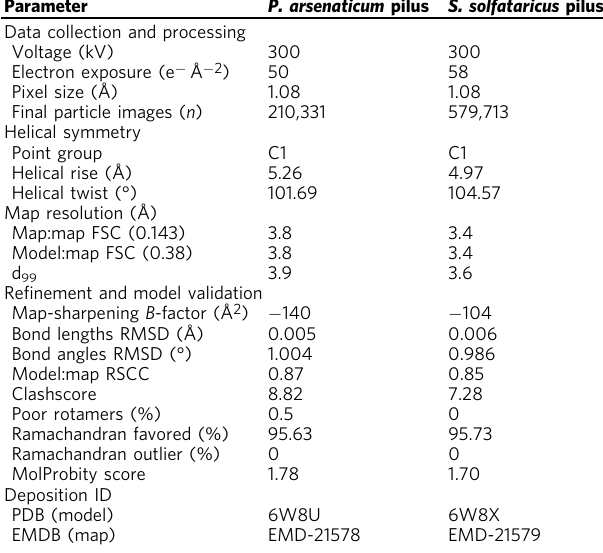
Table 1 Cryo-EM and re fi nement statistics of the P. arsenaticum and the S. solfataricus